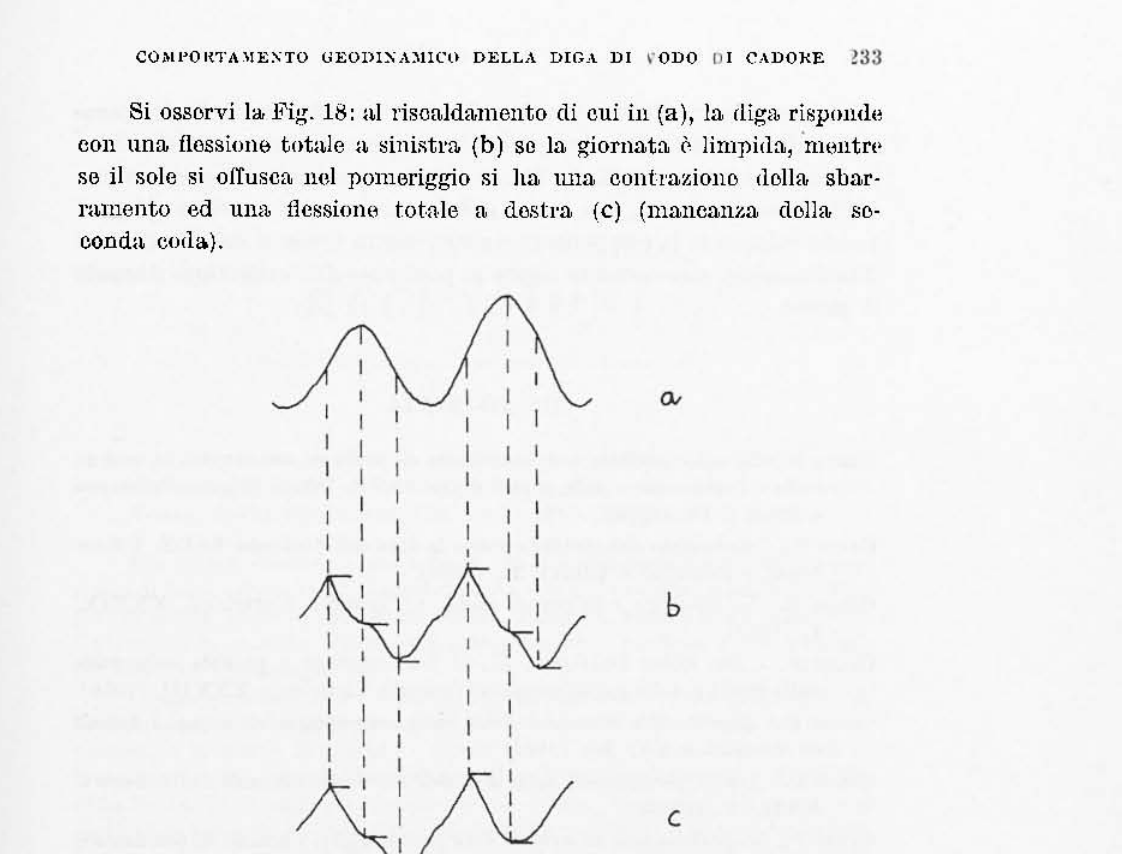
Fig. 18 - Diga di \"odo a) csempio di allllll'nto della tl'mj1l'ratllra ltll'llia: b) risposta (Iella eompol\l'ntl' ;.til\i~tra.·,le~tra all'allllll'nto ,Ii cui in a),